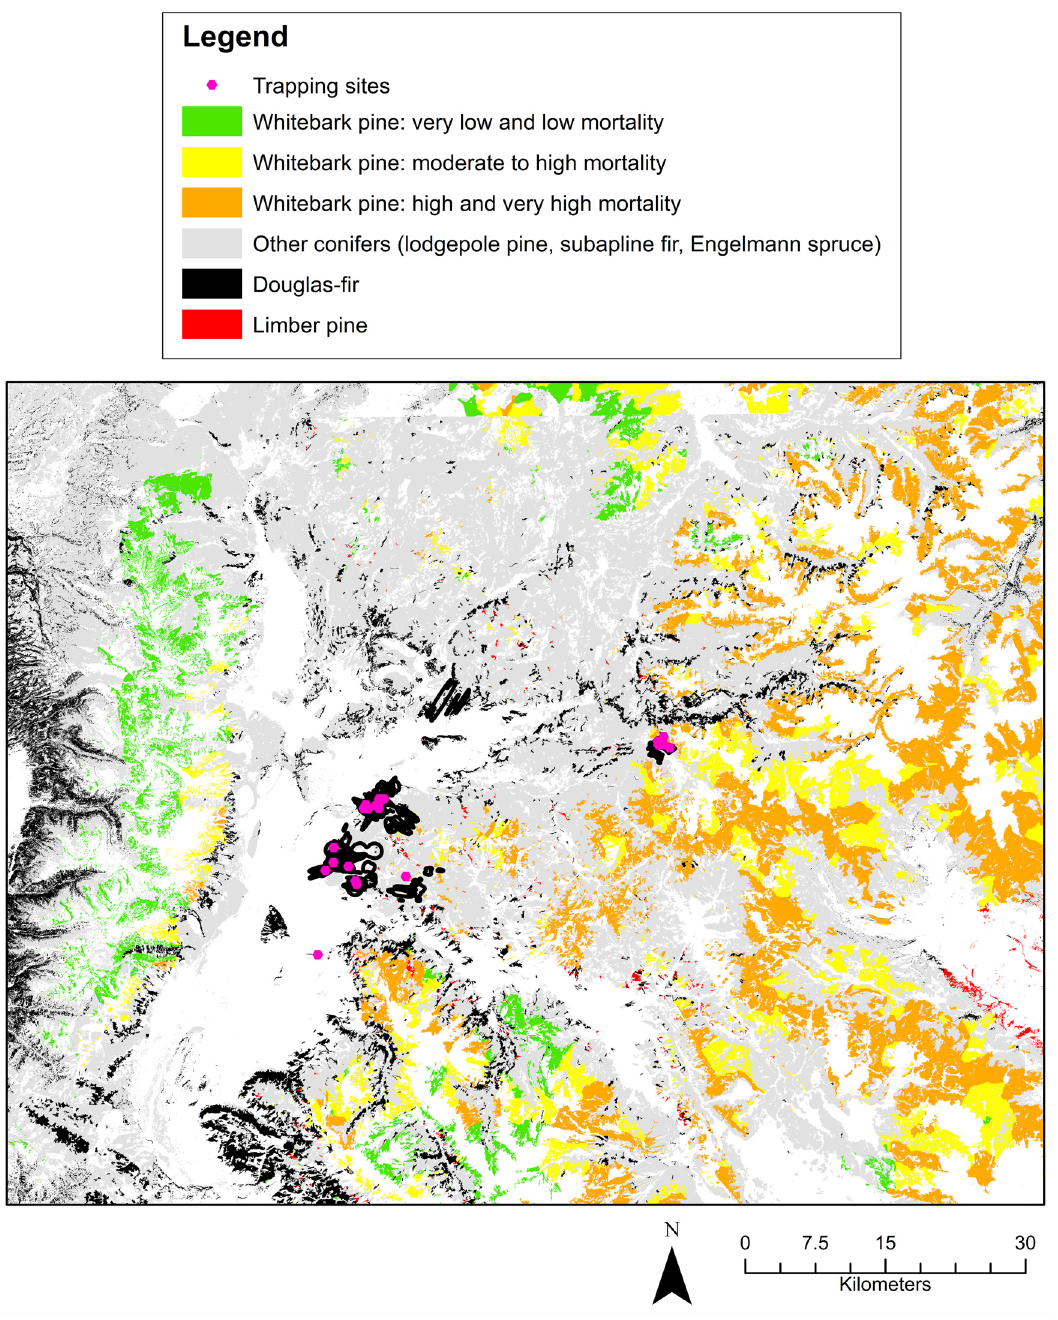
Fig 1. Trapping locations, individual home ranges, and available habitat. Only trapping sites where individuals were successfully captured are shown. Specific whitebark pine categories were merged for better visualization. Burned habitat is not shown because it is not possible to see at the scale of the